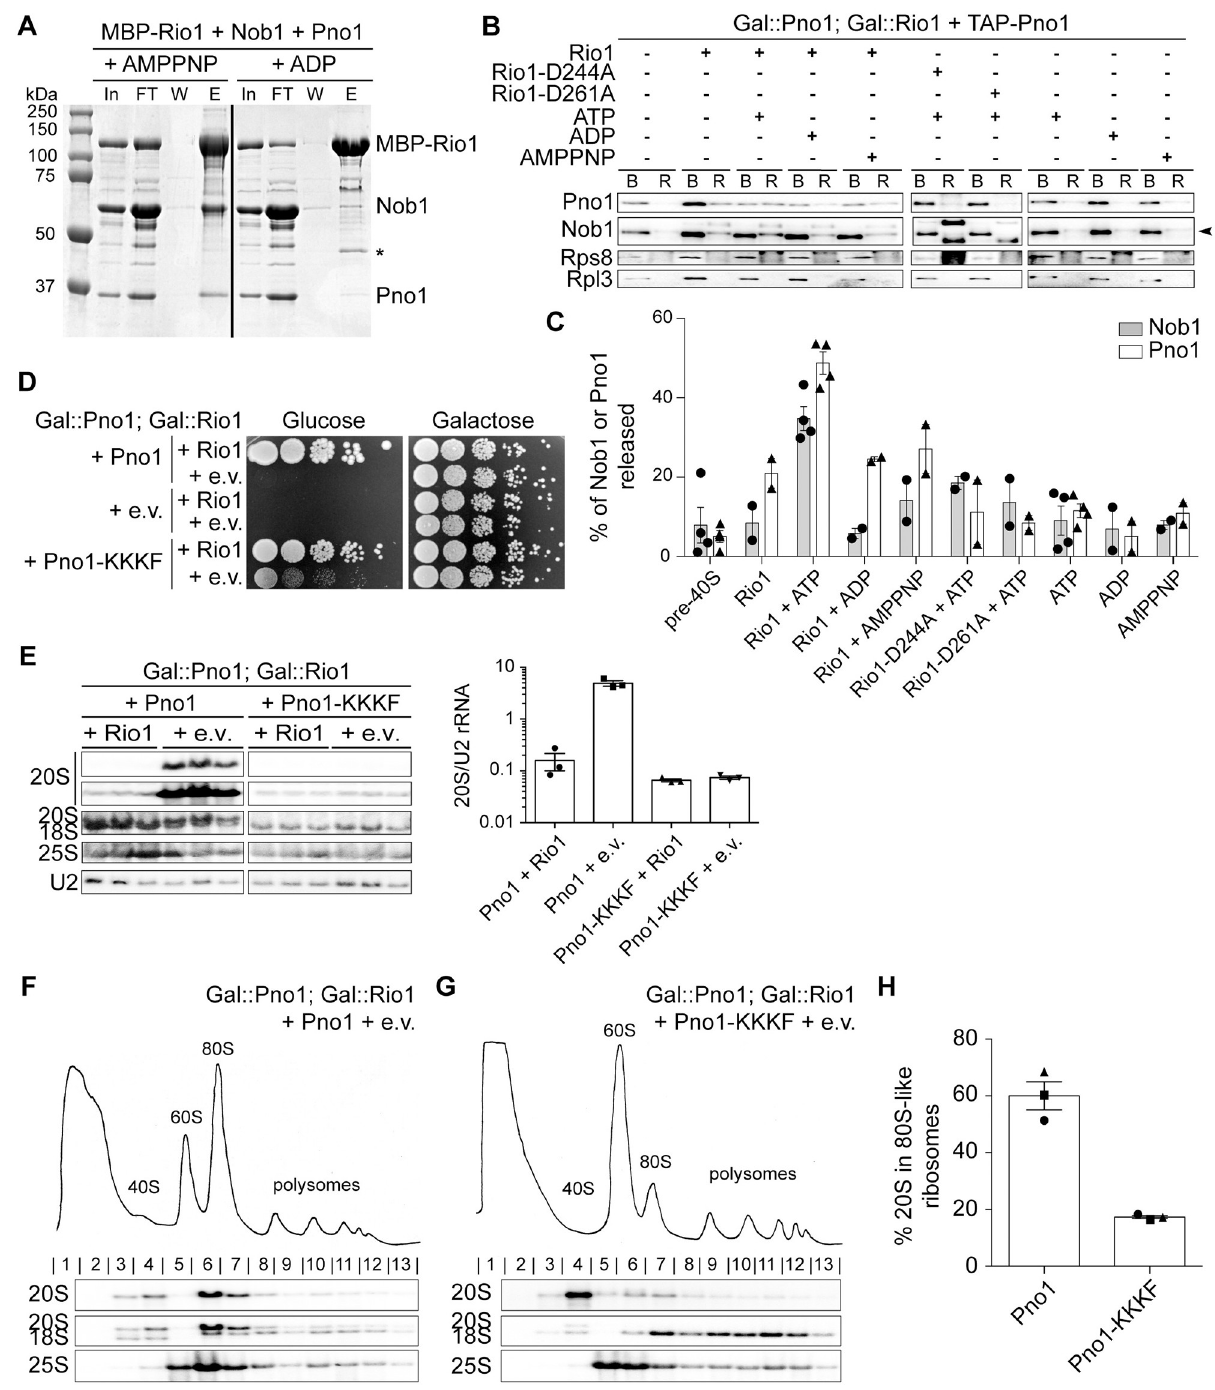
Fig 4. Rio1 stimulates release of Nob1 and Pno1 from the pre-40S ribosome. (A) Rio1 binds Nob1 and Pno1 in the presence of the nonhydrolyzable ATP analog AMPPNP. Shown are Coomassie-stained SDS-PAGE gels of protein binding assays using purified, recombinant MBP-Rio1, Nob1, and Pno1 in the presence of AMPPNP or ADP. The order of the samples was edited for clarity. � MBP. See also S4 Fig. (B) Western blot analysis of a release assay upon addition of purified, recombinant Rio1, Rio1-D244A, or Rio1-D261A and ATP, ADP, or AMPPNP. The arrowhead denotes the band corresponding to Nob1. (C) Quantification of the release assay western blot. The percent of Nob1 and Pno1 released from the ribosome compared with the total Nob1 or Pno1 in each sample. Data are the average of two to four biological replicates, and error bars indicate SEM. (D) Growth of cells expressing either WT Pno1 or Pno1-KKKF (K208E/K211E/K213E/F214A) and either an e.v. or Rio1 were compared by 10-fold serial dilutions on glucose or galactose dropout plates. See also S5 Fig. (E) Left: northern blot analyses of total cellular RNA from cells in panel D grown in glucose for 16 h. Samples were run on the same gel, and the order was edited for clarity. Right: 20S pre-rRNA accumulation was normalized to U2 snRNA in these cells.